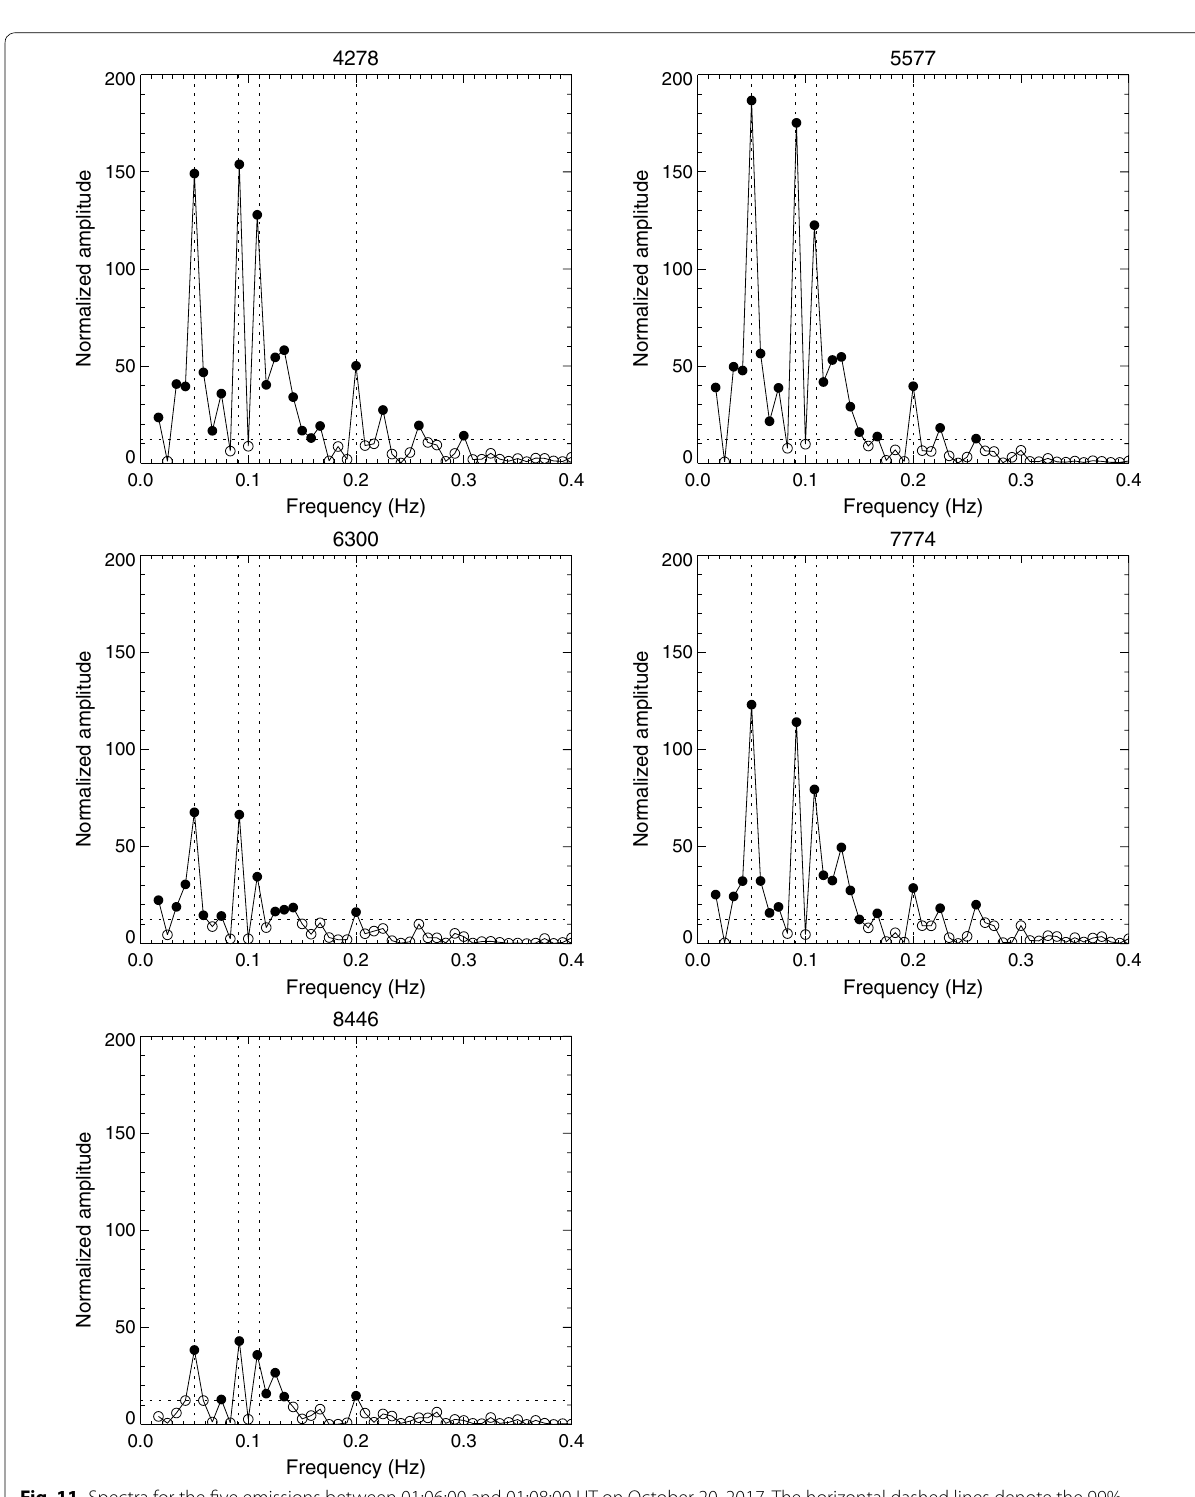
Fig. 11 Spectra for the five emissions between 01:06:00 and 01:08:00 UT on October 20, 2017. The horizontal dashed lines denote the 99% significance level. The vertical dotted lines denote oscillations of 1/5, 1/9.1, 1/11, and 1/20 Hz (i.e., periods being 5, 9.1, 11, and 20 s, respectively). Closed (open) circles denote data whose values are greater (smaller) than the 99% significance